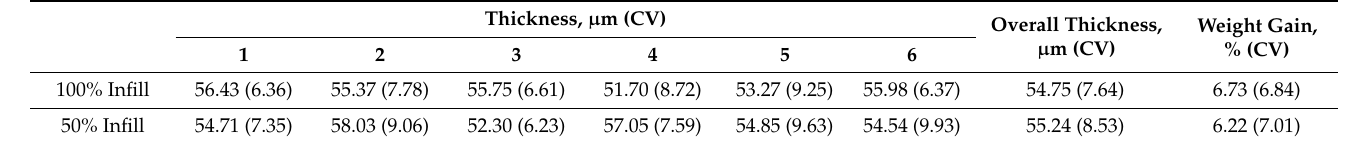
Table 5. Thickness and weight gain data relevant to coated I-shaped samples printed by setting different